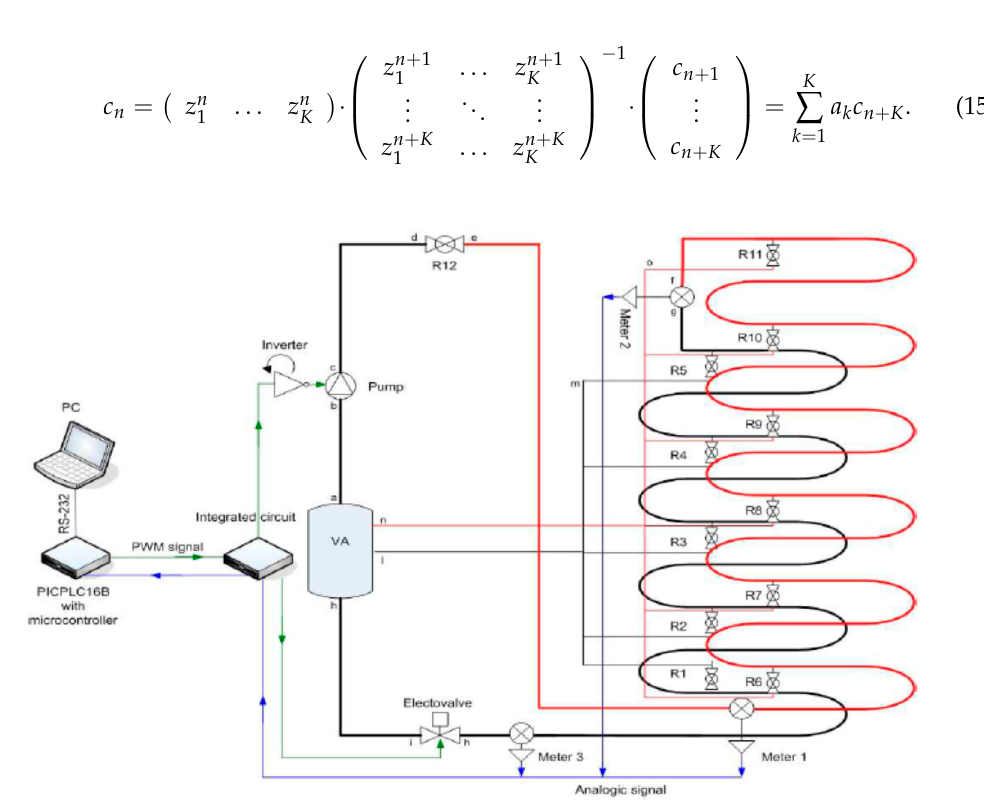
Figure 3. Partial view of zig-zag pipeline, first part of 70 m and back part of 50 m, serving as a hydraulic circuit for leak detection.